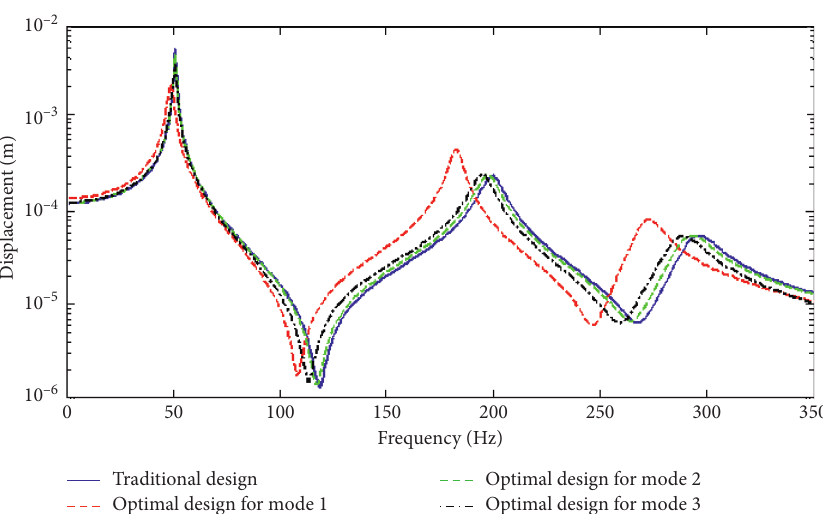
Figure 6: Comparison of the amplitude of frequency response function of traditional design and optimal designs.